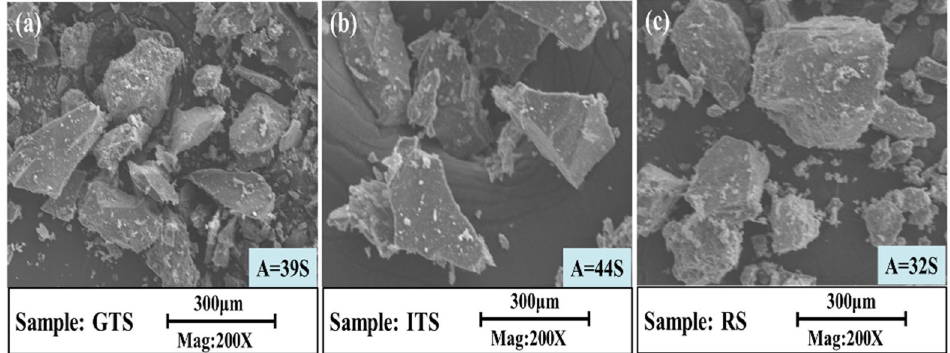
Figure 5. Microstructure and angularity of fine aggregates ( a ) GTS, ( b ) ITS, ( c ) RS.